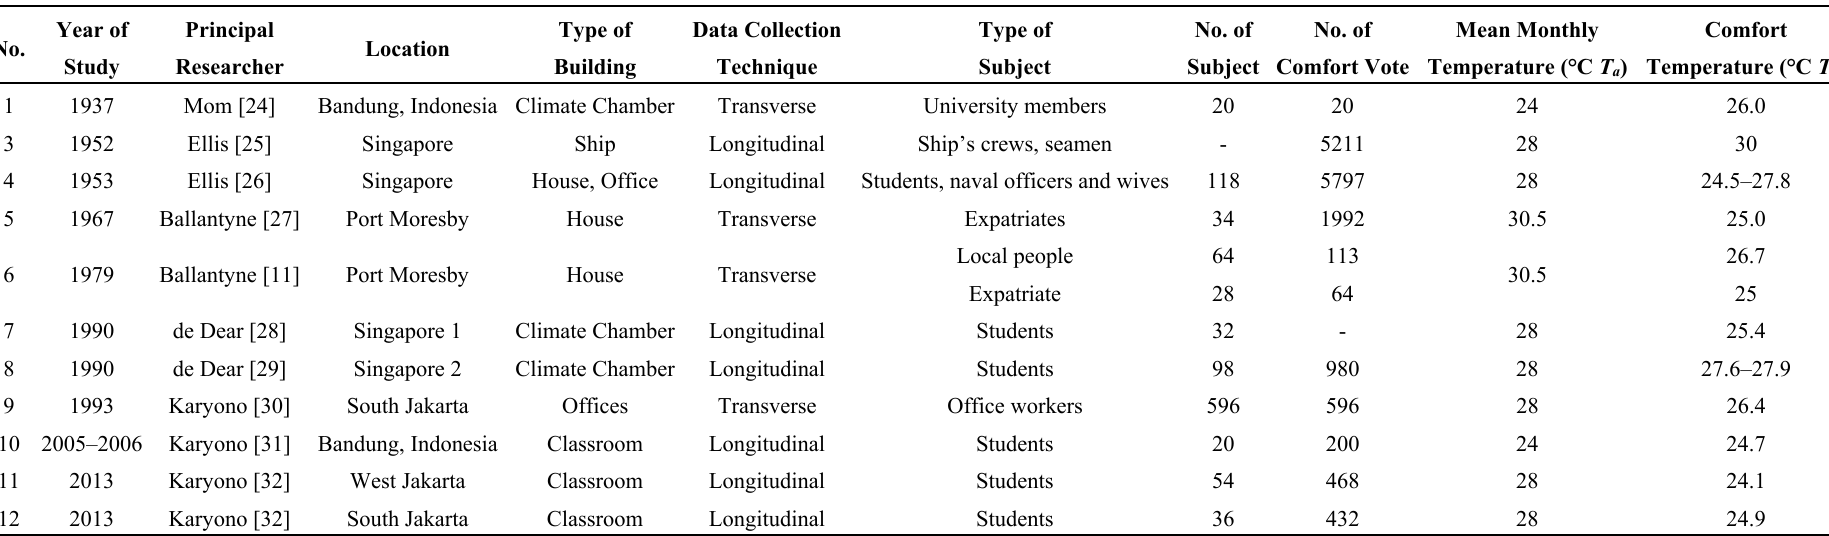
Table 5. Subjects comfort temperature in some previous comfort studies in Southeast Asian countries expressed in air temperature ( T a